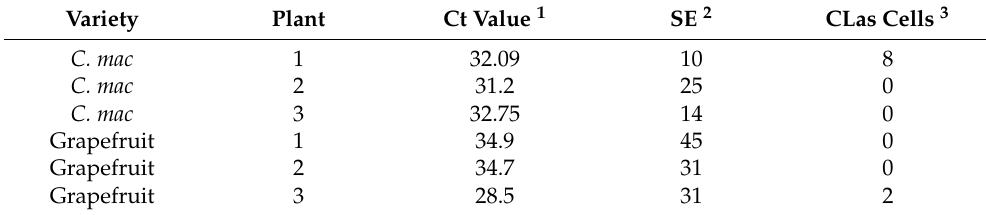
Table 3. Comparison between Candidatus Liberibacter asiaticus quantification by qPCR and TEM. Variety Plant Ct Value 1 SE 2